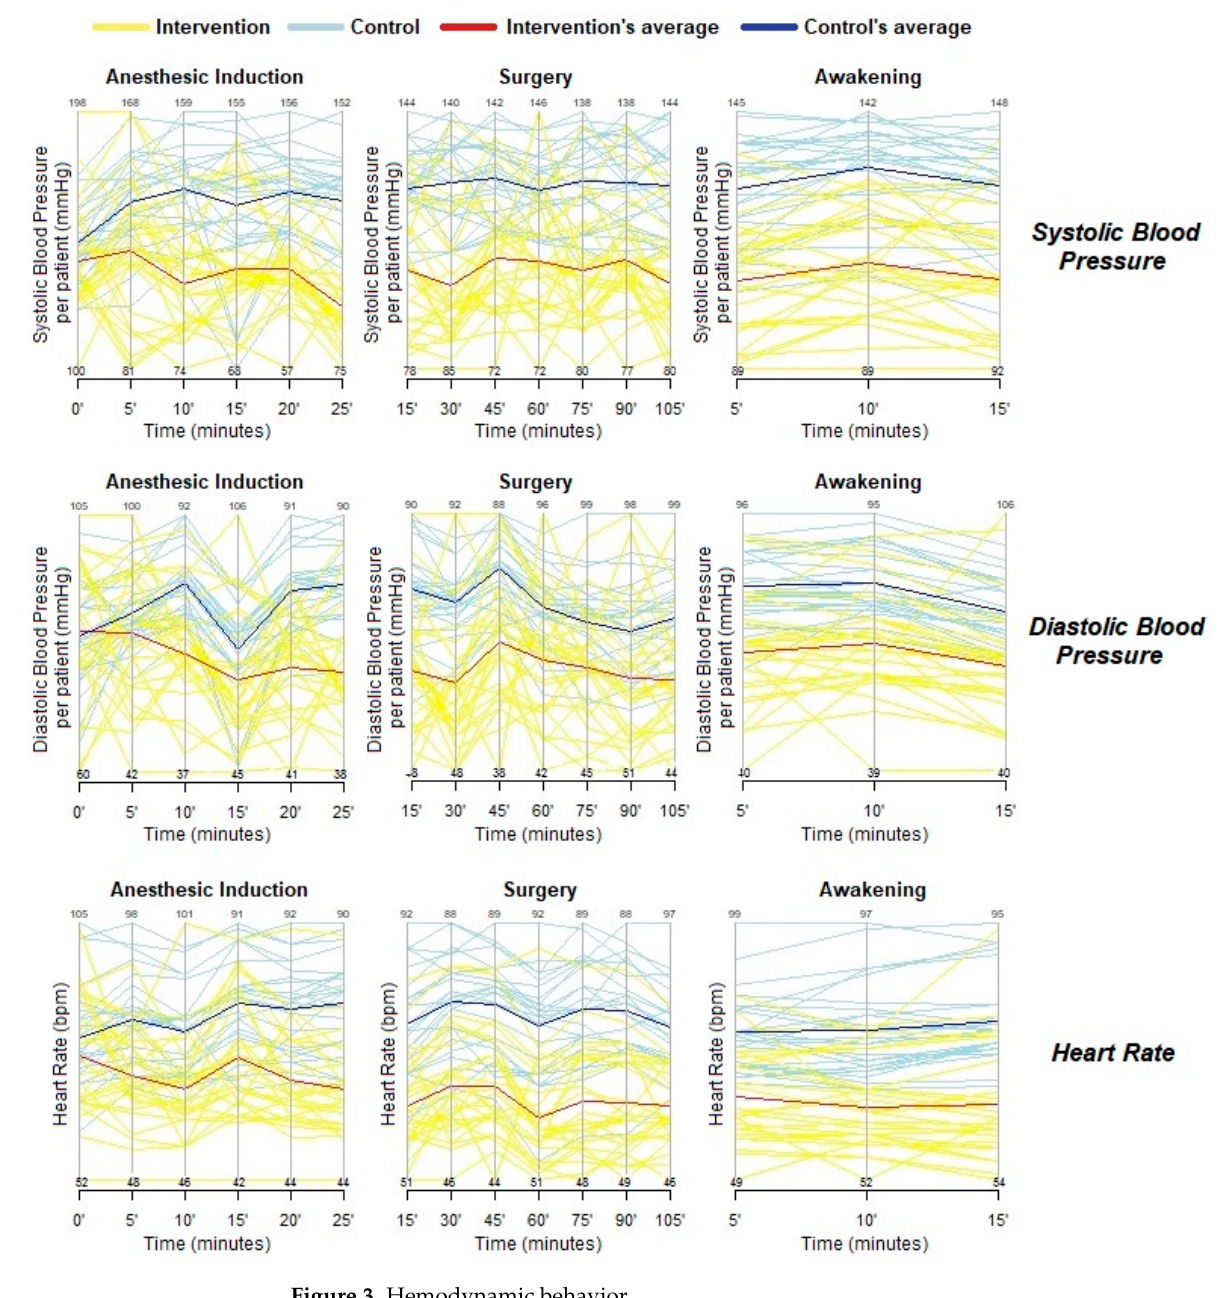
Figure 3. Hemodynamic behavior.